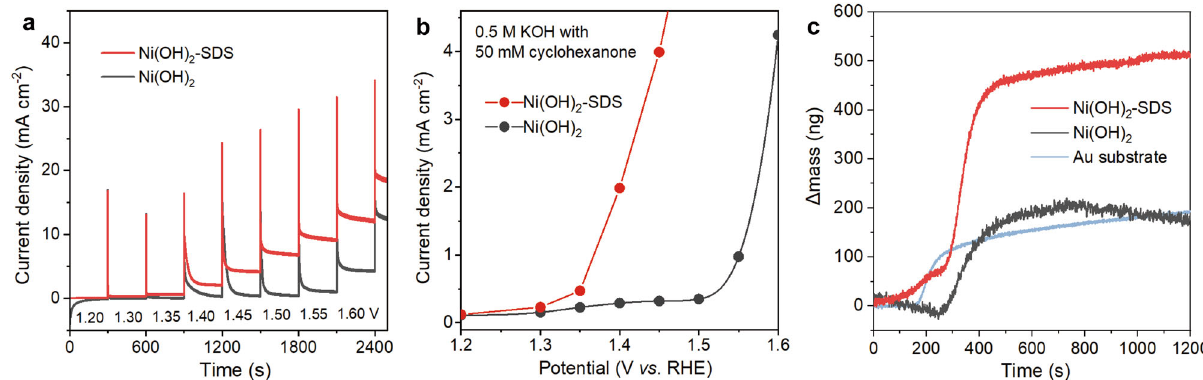
Fig.4|Mechanisticinvestigationofcyclohexanonetransportandenrichment. a I – t curvesofNi(OH) 2 -SDSandNi(OH) 2 atdifferentpotentials(VvsRHE)innormal pulsevoltammetry. b ThecorrespondingnormalpulsevoltammogramsofNi(OH) 2 - SDS and Ni(OH) 2 . The measurements were conducted in 0.5M KOH with 50mM